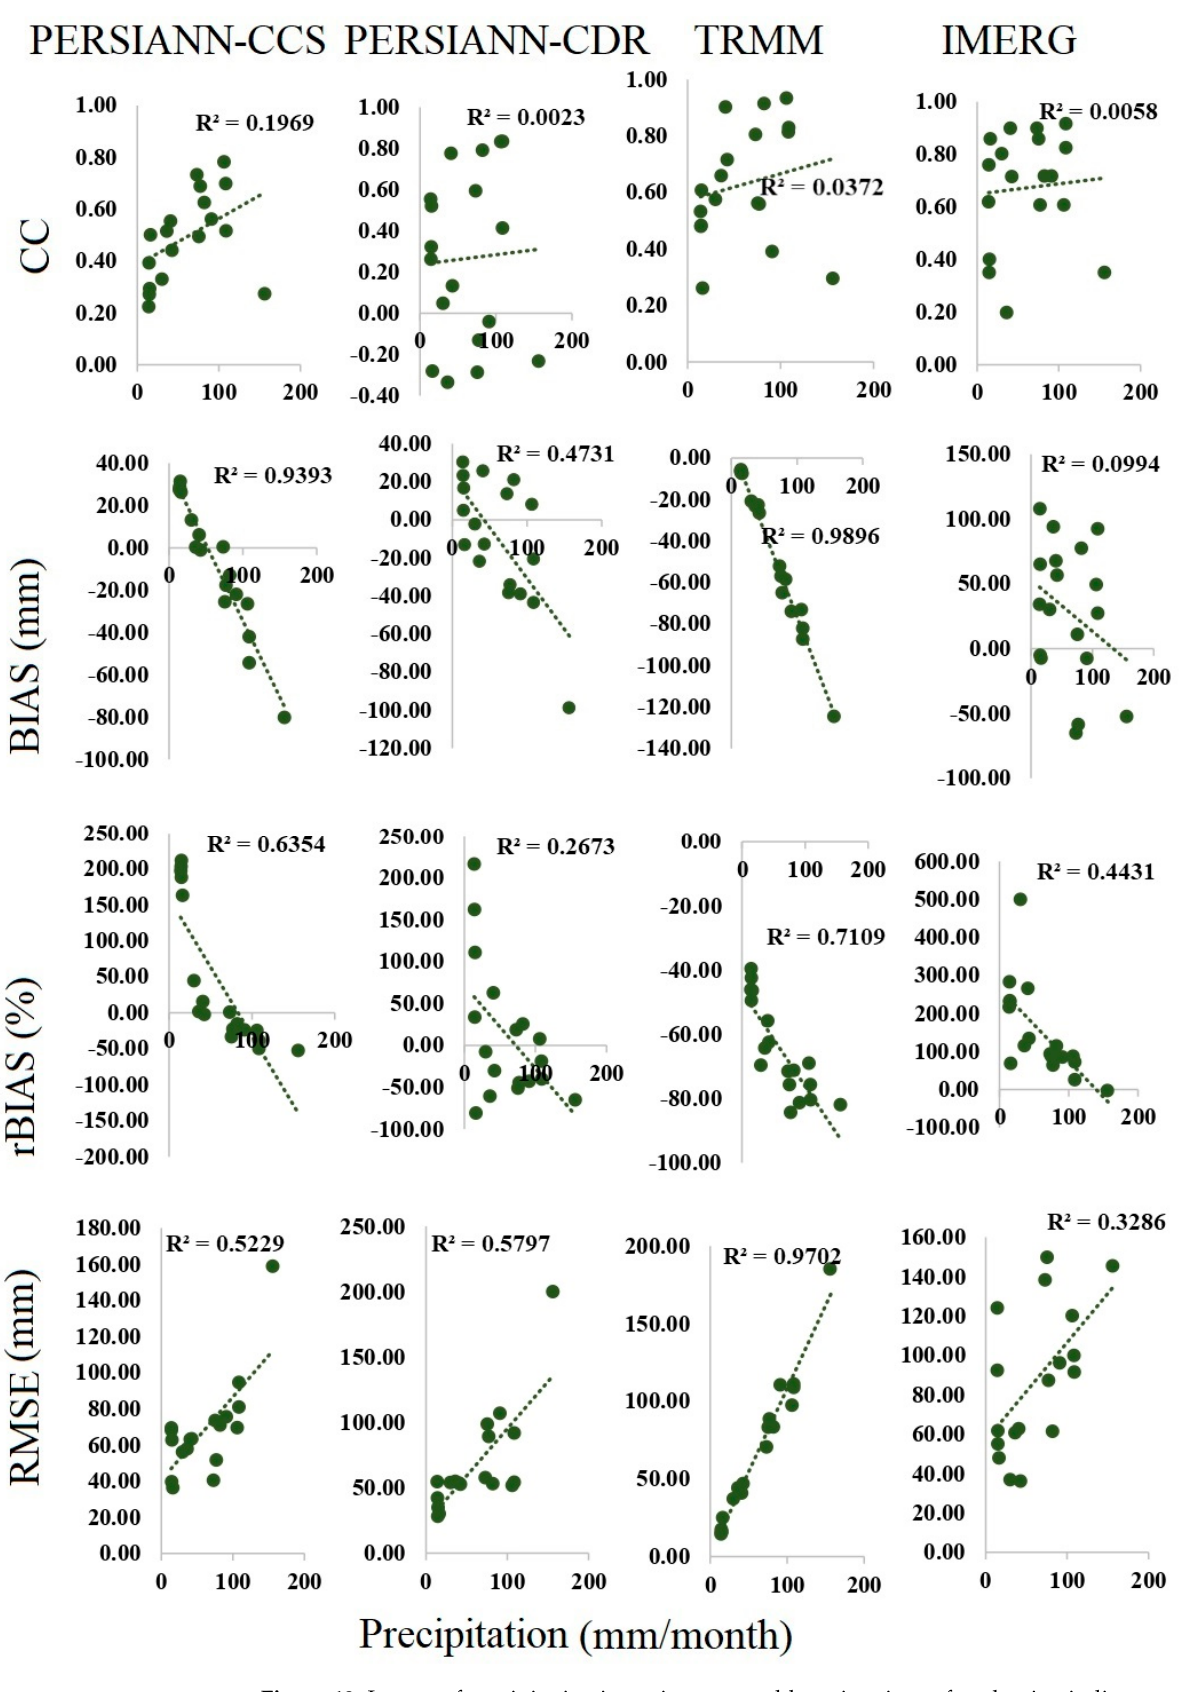
Figure 13. Impact of precipitation intensity on monthly estimations of evaluation indices .